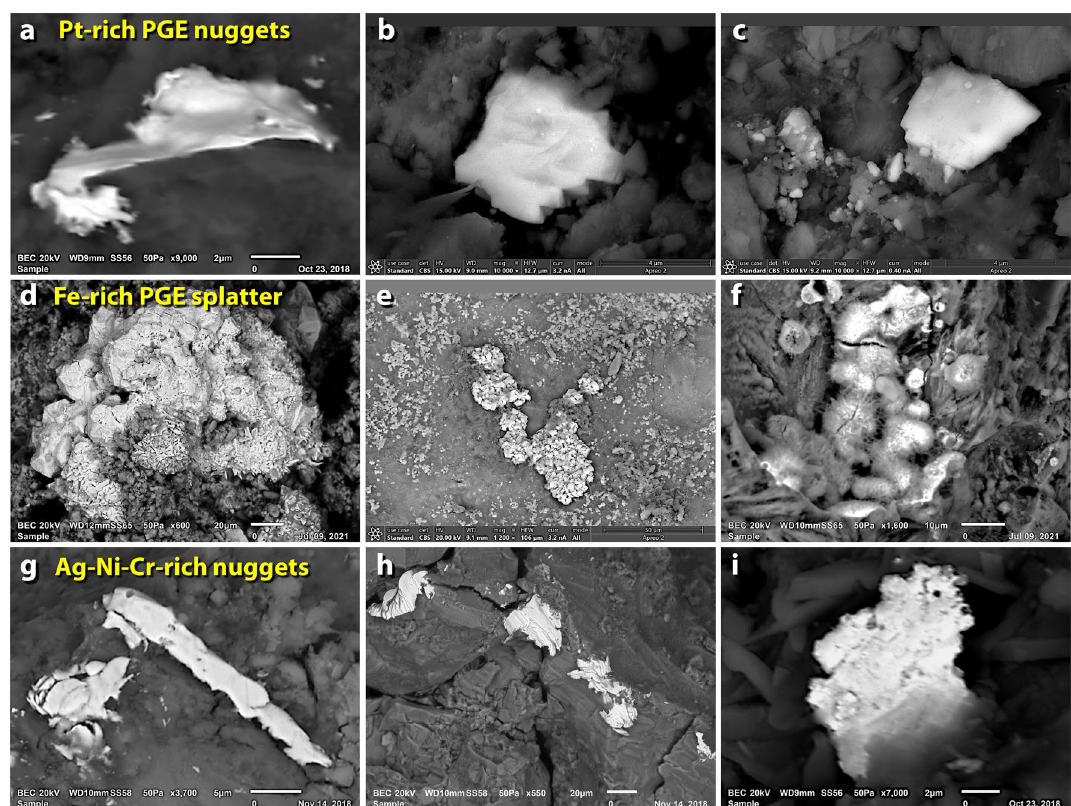
Figure 34. SEM images of nuggets of melted metals in mudbrick meltglass from the palace. ( a )–( c ) Pt-dominant TeH nuggets enriched in ruthenium (Ru), rhodium (Rh), palladium (Pd), osmium (Os), iridium (Ir), and platinum (Pt). ( d )–( f ) Fe-dominant TeH splatter is also enriched in PGEs. ( g )–( i ) Nuggets enriched in varying percentages and combinations of nickel (Ni), chromium (Cr), copper (Cu), and silver